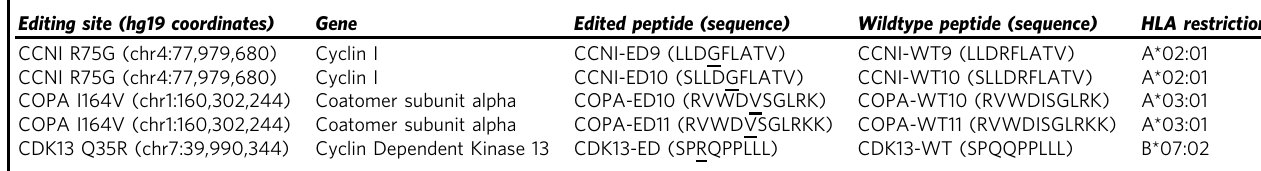
Table 1 List of HLA-bound edited peptides (ED) and their non-edited (WT) counterparts as identi fi ed by MS-based immunopeptidomics from primary human tissue Editing site (hg19 coordinates) Gene Edited peptide (sequence) Wildtype peptide